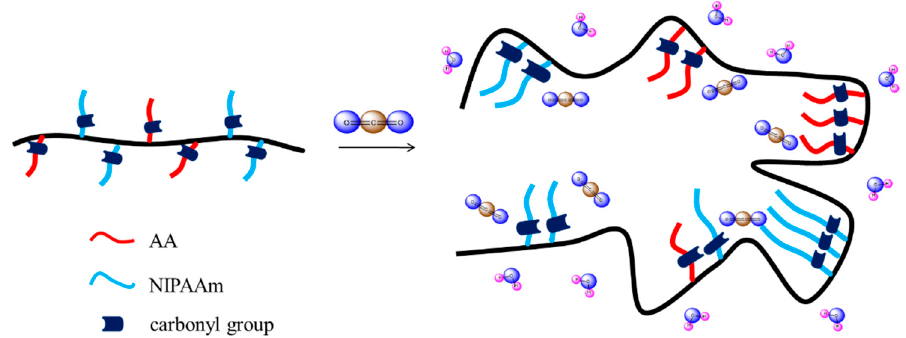
Scheme 5. Possible interactions in PNIPAAm- co -PAA random copolymers under a CO 2 atmosphere.